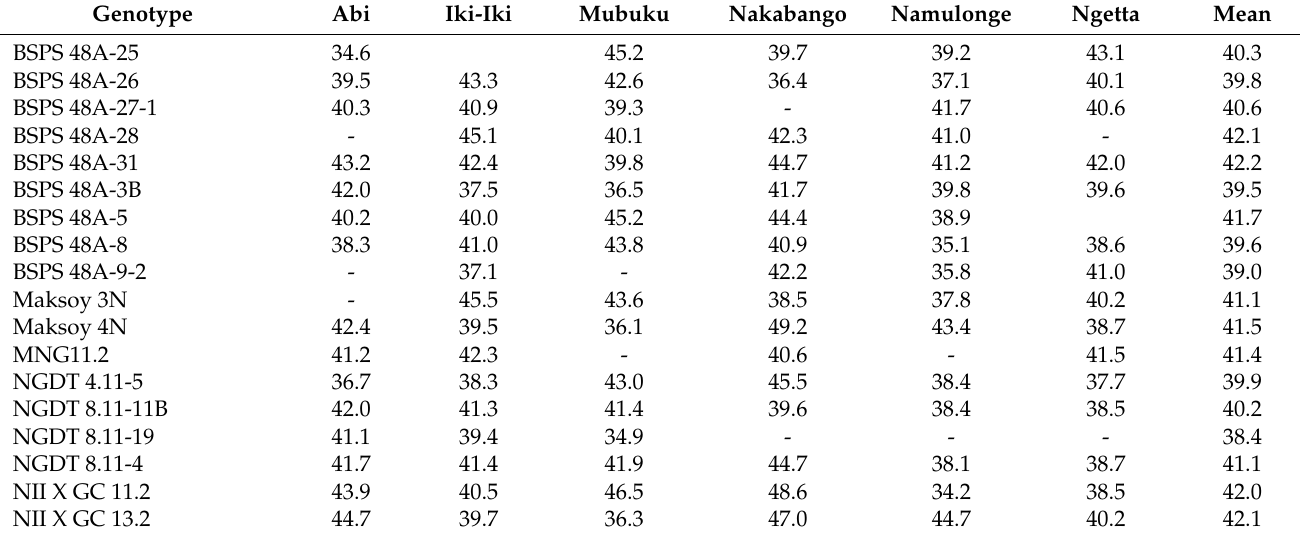
Table 4. Protein content (%) of 30 soybean genotypes evaluated in six locations in Uganda.